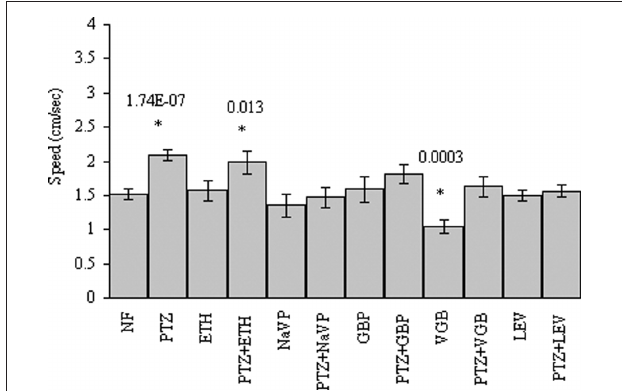
Figure 3 | Behavioral pharmacology of AeDs. Mean ± SE ( n = 24) of climbing speed of flies treated and untreated with AED after PTZ withdrawal, and treated with AED alone. Note that climbing speed of flies treated with an AED after PTZ withdrawal is either insignificantly or less significantly different from the control (NF) group, compared to flies not treated with an AED after PTZ withdrawal. PTZ indicates no AED treatment after PTZ withdrawal, AED abbreviation indicates AED alone treatment, PTZ + AED abbreviation indicates AED treatment after PTZ withdrawal. Speed in the control (NF) group was compared with various treatment groups, in pair-wise comparisons. *Indicates nominal p -value. See text for details.